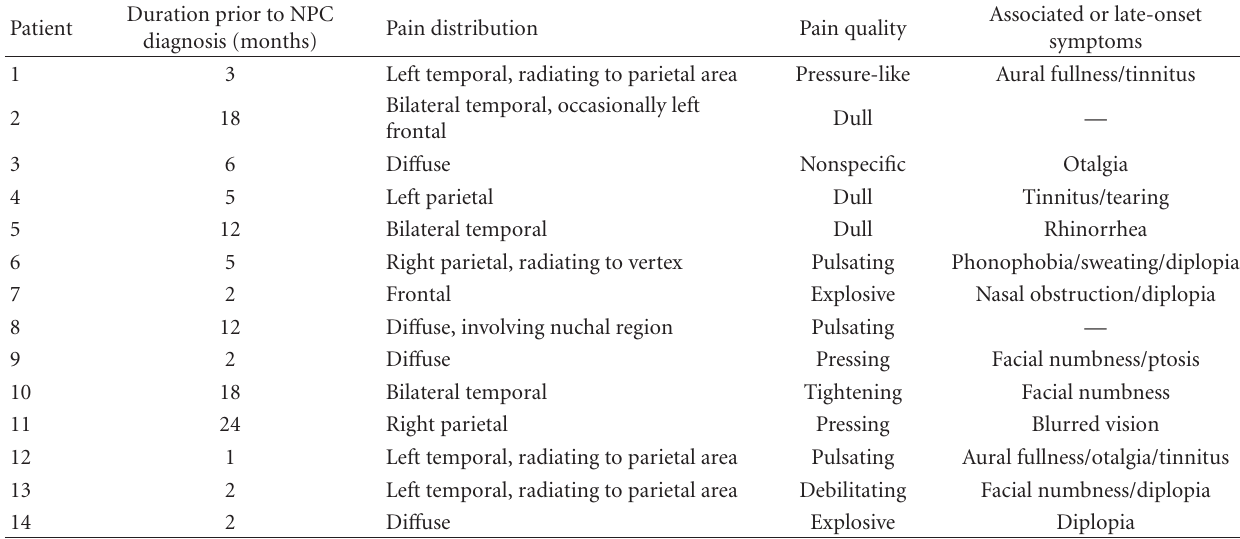
Table 2: Features of the